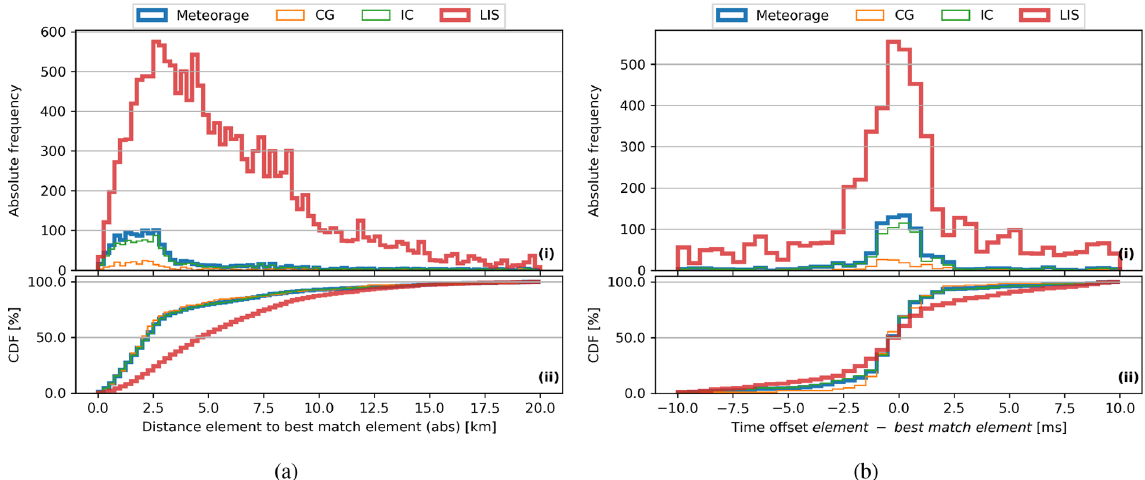
Figure 6. Best match distance (a) and time offset (b) between a given Meteorage pulse or stroke (LIS event) and the closest ISS-LIS event (Meteorage pulse or stroke). Histogram (i) and cumulative distribution function (ii) with bins of 0.25km (a) and 0.5ms (b) . Analyzed pulses and strokes (events) belong to flashes with matches (spatial and temporal filters), while the pulses and/or strokes (events) of unmatched flashes are not considered. For Meteorage, the discharge types (CG, IC) are distinguished. Only elements with absolute timing offsets of less than 10ms are included in the plotted time offset distribution. A positive time indicates that the given element occurred later than the best